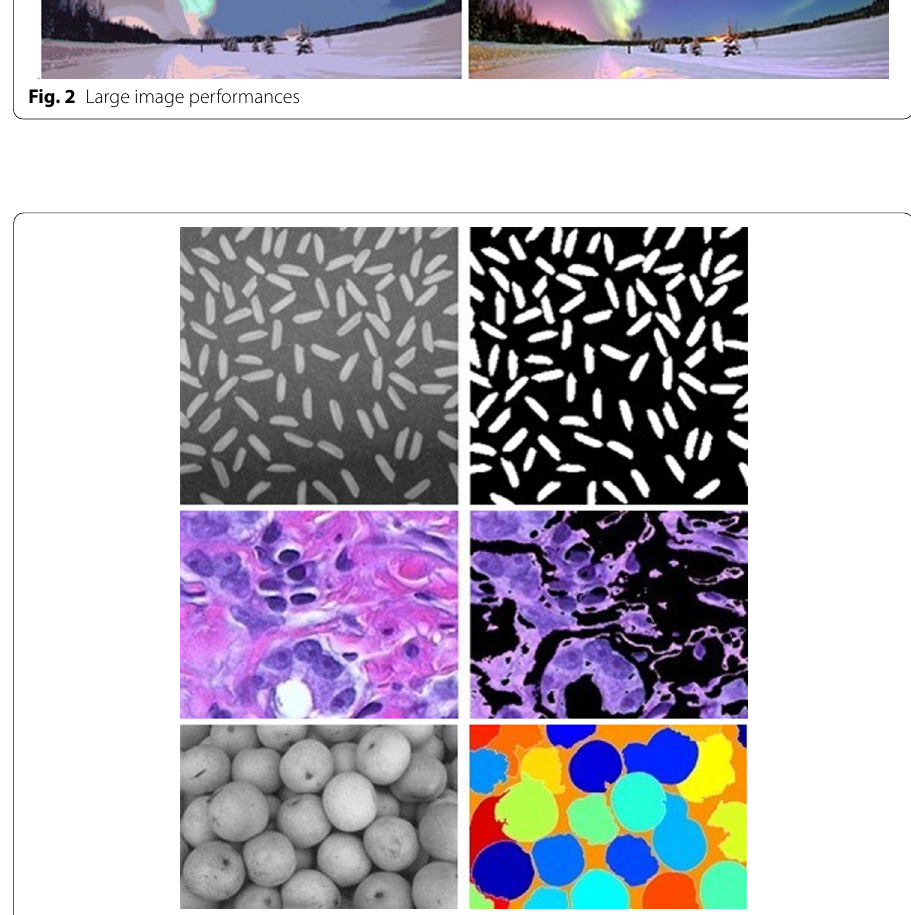
Fig. 3 Texture filters for SHVN and CIFAR10